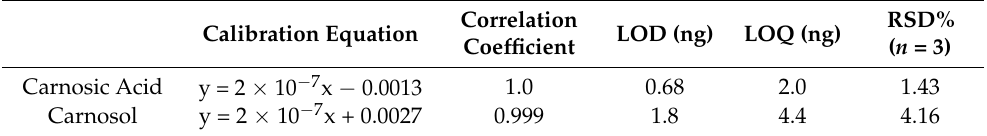
Table 1. Calibration equations, LODs, LOQs, and repeatability calibration curves for compounds carnosic acid and carnosol.